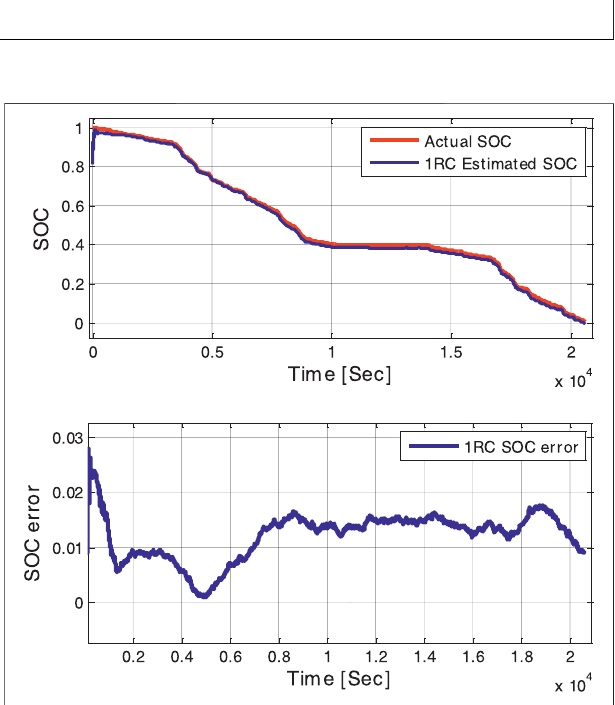
FIGURE 13 | Augmented ECM based AEKF_1RC with 5% bias